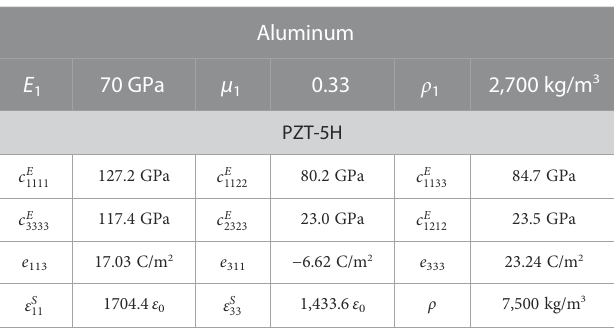
TABLE 1 Material